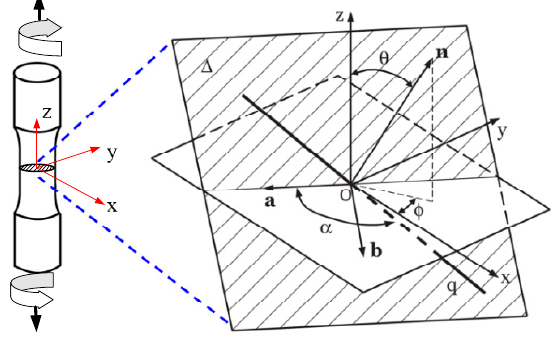
Figure 1. The definition of critical plane.